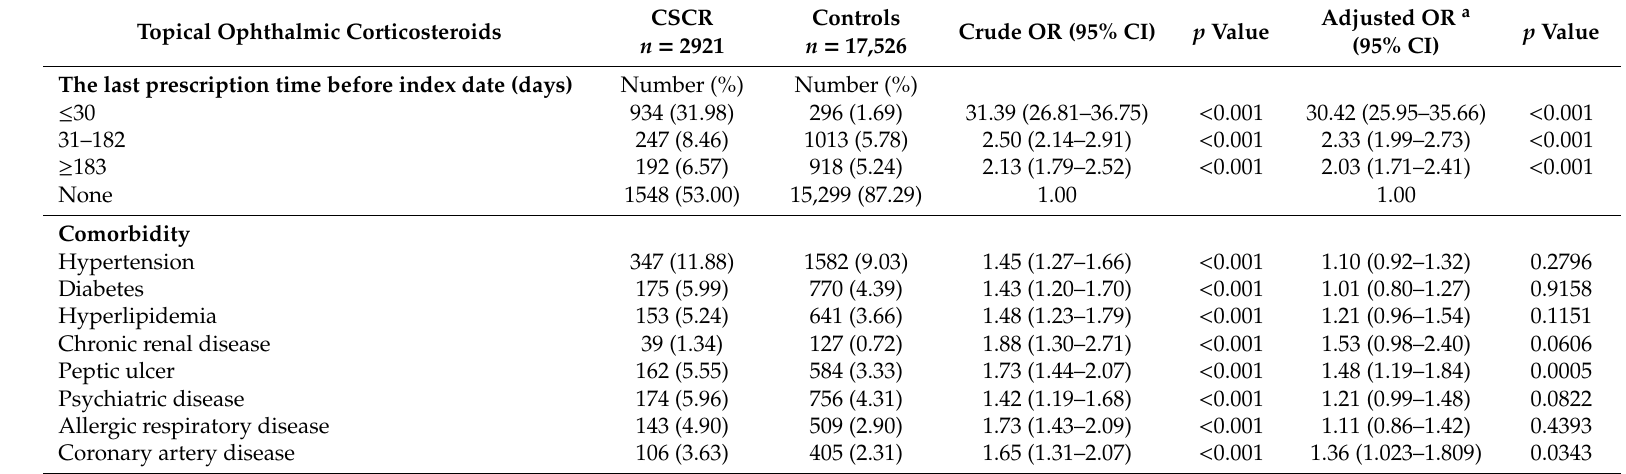
Table 2. Odds ratios (OR) were obtained by univariate and multivariate logistic regression for various prescription times of topical ophthalmic corticosteroids use between CSCR patients and